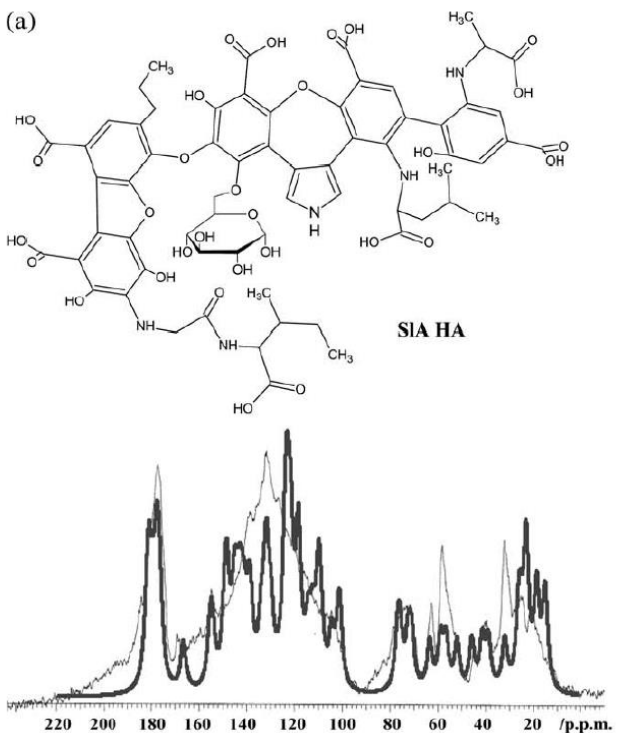
Figure 31. Top (a). Structural elements suggested for humic acid. Bottom. Spectrum behind (thin line) is the 13 C NMR spectrum in solution. Spectrum in front is the predicted 13 C NMR